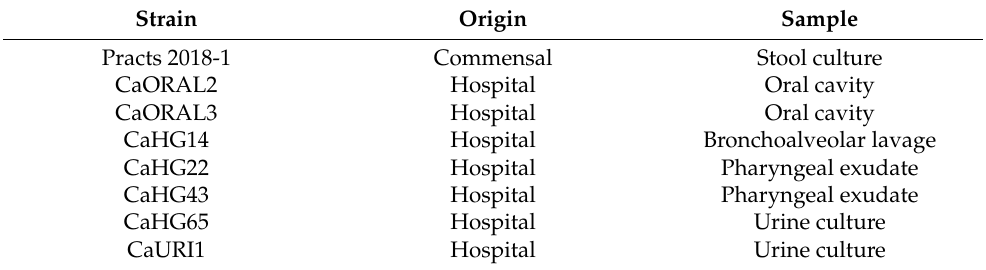
Table 2. C. albicans strains selected in our competitive pool commensalism